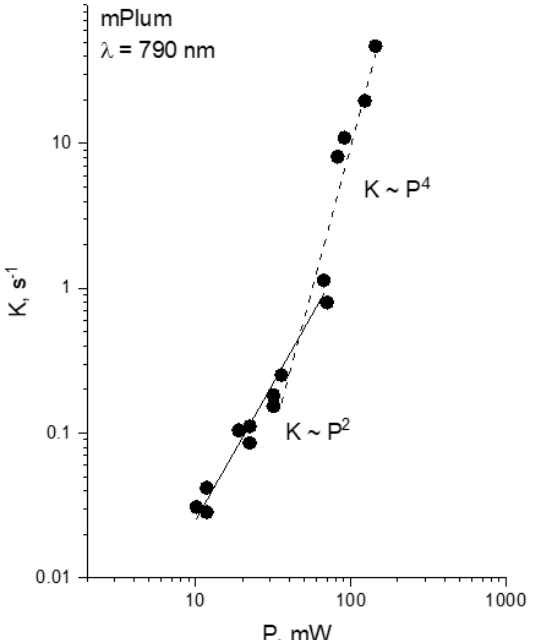
Figure 5. Power dependence of the initial bleaching rate of mPlum at 790 nm, presented in double logarithmic scale.